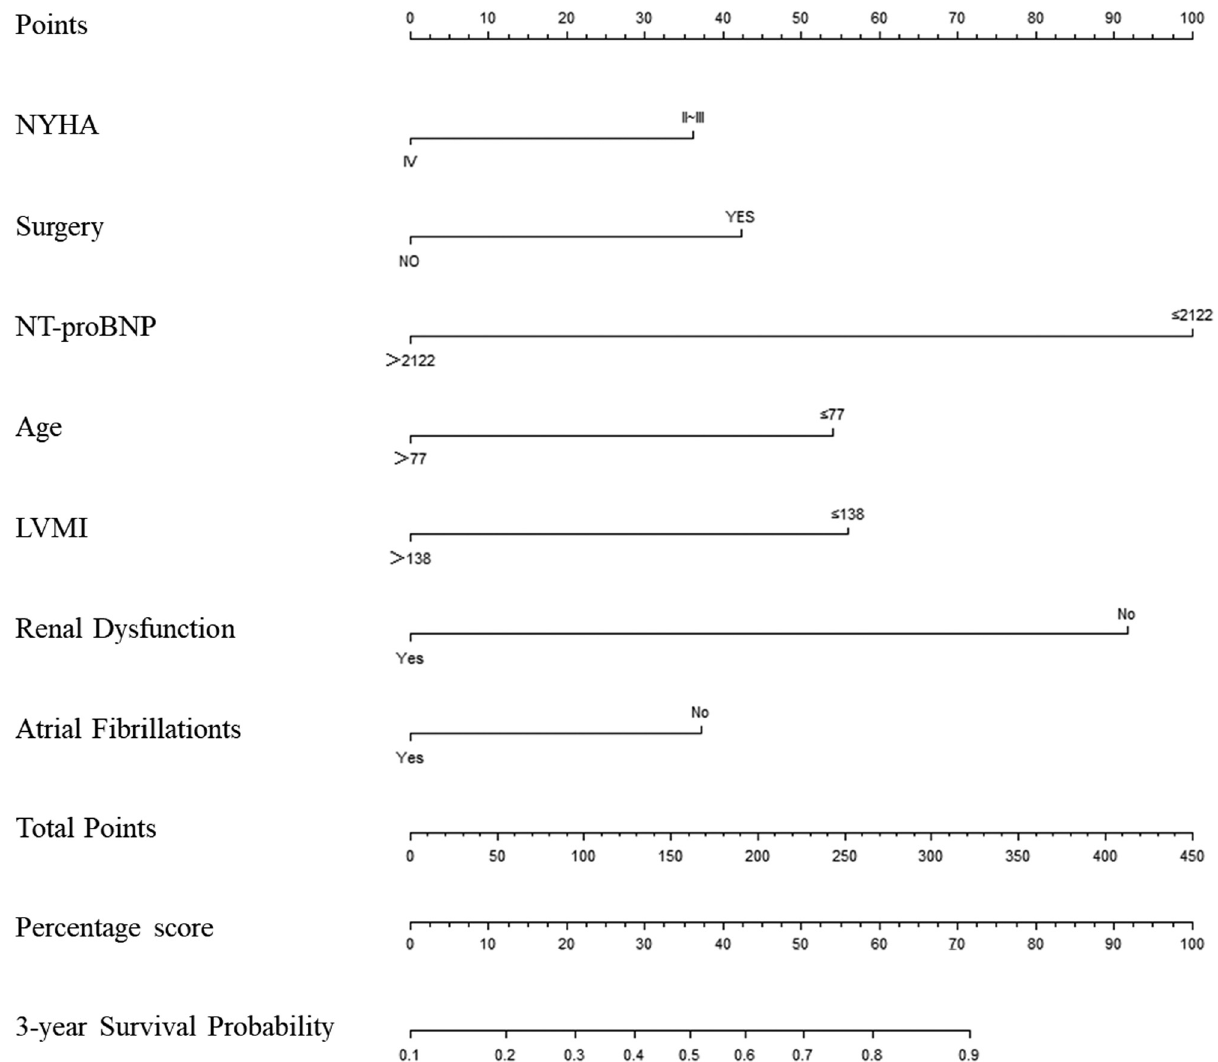
Figure 3: Nomogram. Abbreviations: NYHA, New York Heart Association; NT - proBNP, N - terminal pro - B - type natriuretic peptide; LVMI, left ventricular mass